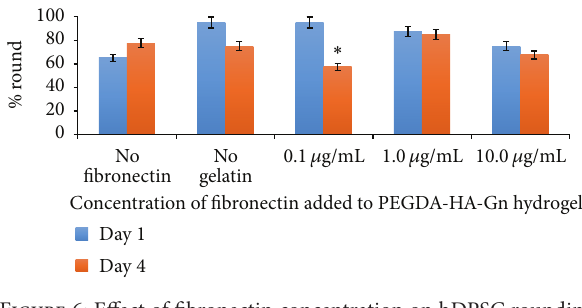
Figure 6: Effect of fibronectin concentration on hDPSC rounding. Data represents an average of 40 cells/field of view at 20x magnifi- cation. 𝑛 = 3 samples. ∗ 𝑝 < 0.05 .